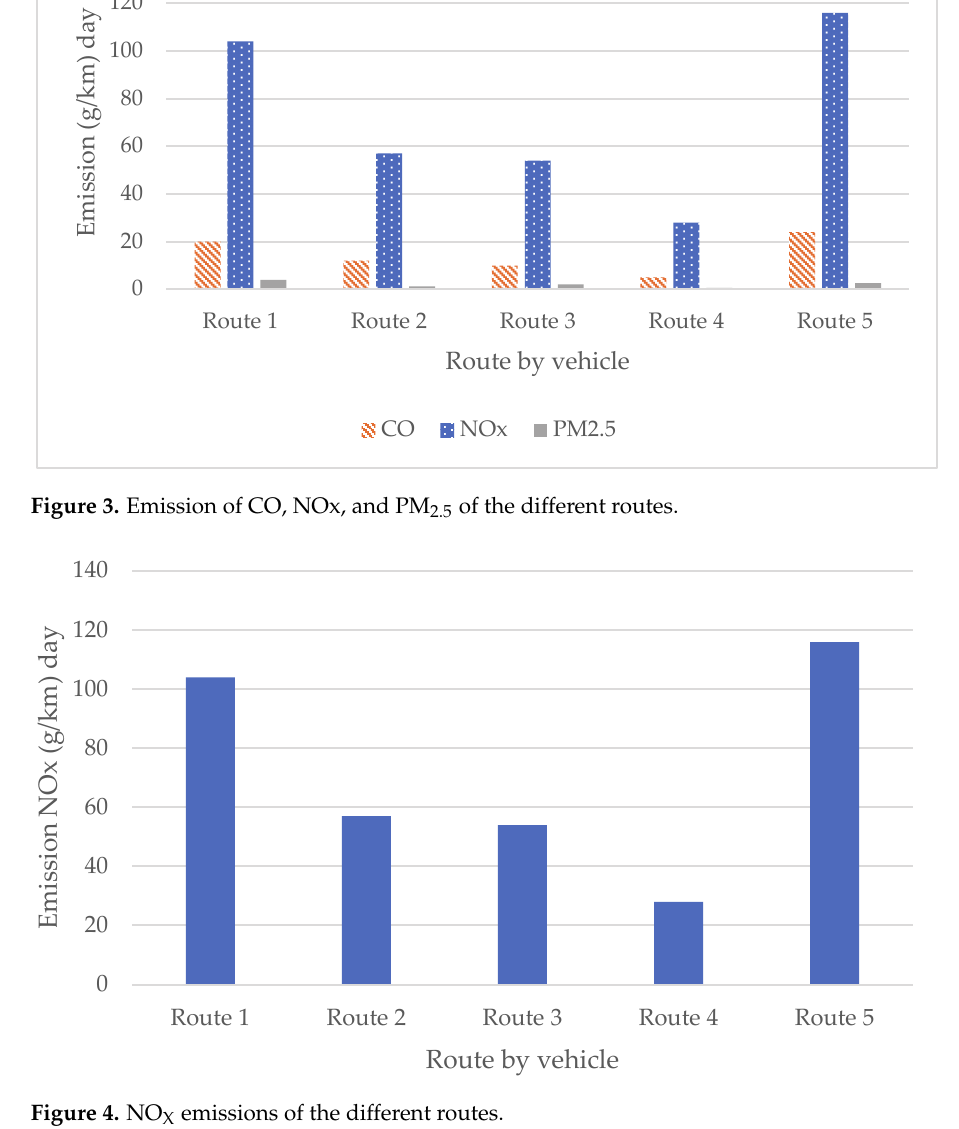
Figure 4. NO X emissions of the different routes.